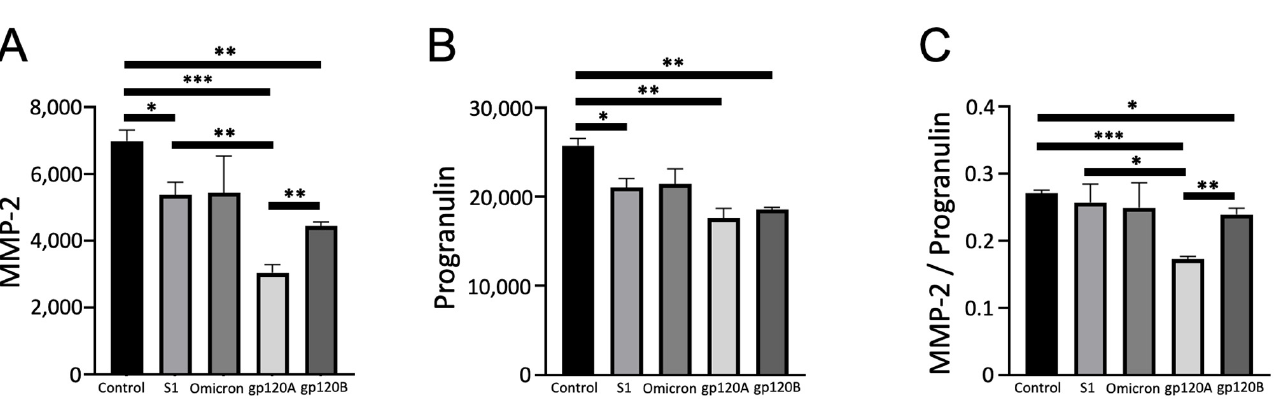
Figure 4. Characteristic of the effects of gp120 proteins of HIV-1 Group M Subtype A and Subtype B on the MMP-2 expression. Human pulmonary artery endothelial cells were treated with SARS-CoV-2 spike proteins S1, Omicron S1, and gp120 of HIV-1 Subtype A (gp120A) or Subtype B (gp120B) at 1 nM for 20 h in triplicate. Expression patterns of various proteins were monitored using R&D Human XL Oncology Array. Bar graphs represent means ± SEM (N = 3 for all groups) of ( A ) MMP-2 expression, ( B ) progranulin expression, and ( C ) the ratio of MMP-2 to progranulin expression. * p < 0.05. ** p < 0.01. *** p < 0.001. The y-axis indicates the mean pixel density of protein spots.